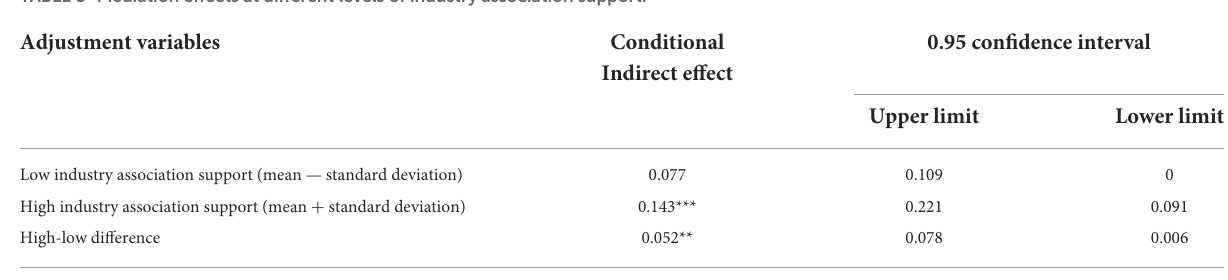
TABLE 8 Mediation effects at different levels of industry association